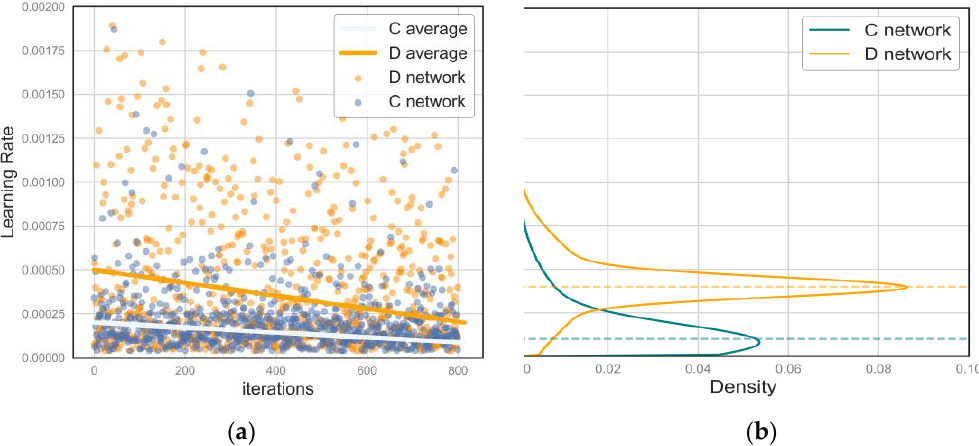
Figure 3. Optimal hyperparameters establishment: ( a ) Search processing of optimal hyperparameters with iterations and hyperparameters fitting using a sliding average; ( b ) Density map of the global hyperparameters. Table 4. Hyperparameters in SCGAN